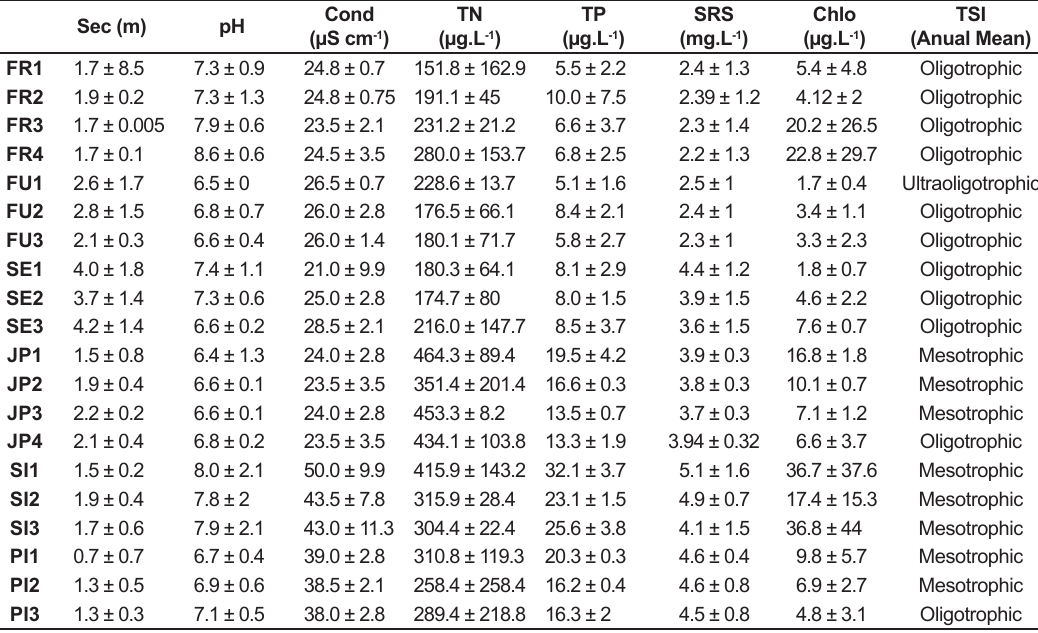
Table 1. Means and standard deviation of abiotic variables in the six studied reservoirs. The other variables were eliminated because of collinearity. Abbreviations: Sec (Secchi depth), pH, Cond (Conductivity), TN (Total nitrogen), TP (Total phosphorus), SRS (Soluble reactive silica), Chlo (Chlorophyll-a), TSI (Trophic State Index). FR (Cachoeira do França), FU (Cachoeira da Fumaça), SE (Serraria), JP (Jurupará), SI (Salto do Iporanga), PI (Paineiras). Numbers refer to sample